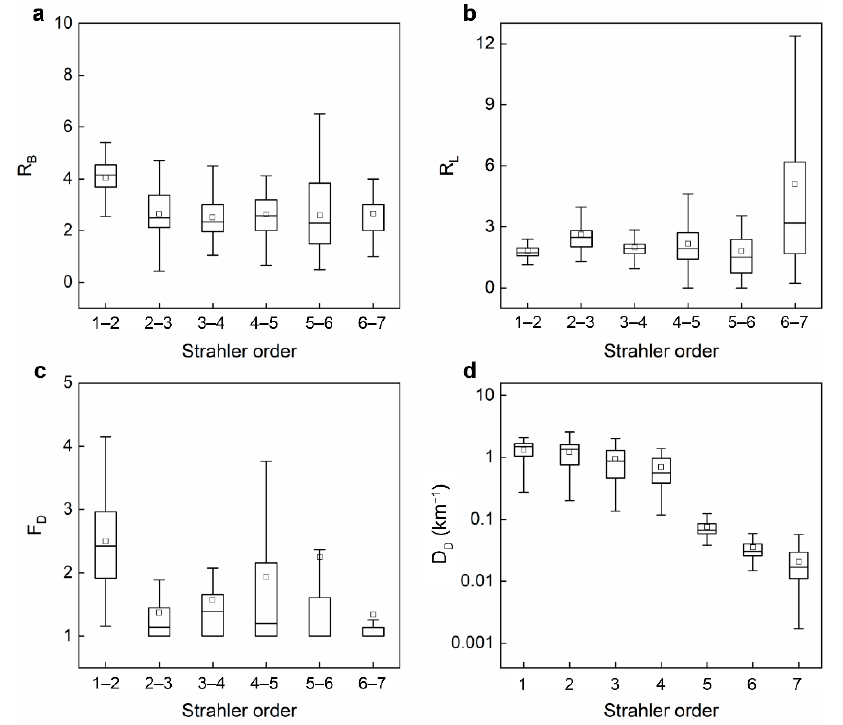
Figure 4. Structural parameters with different Strahler orders for river networks in the Tarim Basin: ( a ) bifurcation ratio (R B ), ( b ) channel len g th ratio (R L ), ( c ) fractal dimension index (F D ), and ( d ) drain- Basin: ( a ) bifurcation ratio (R B ), ( b ) channel length ratio (R L ), ( c ) fractal dimension index (F D ), and age density (D D , km − 1 ). ( d ) drainage density (D D , km − 1